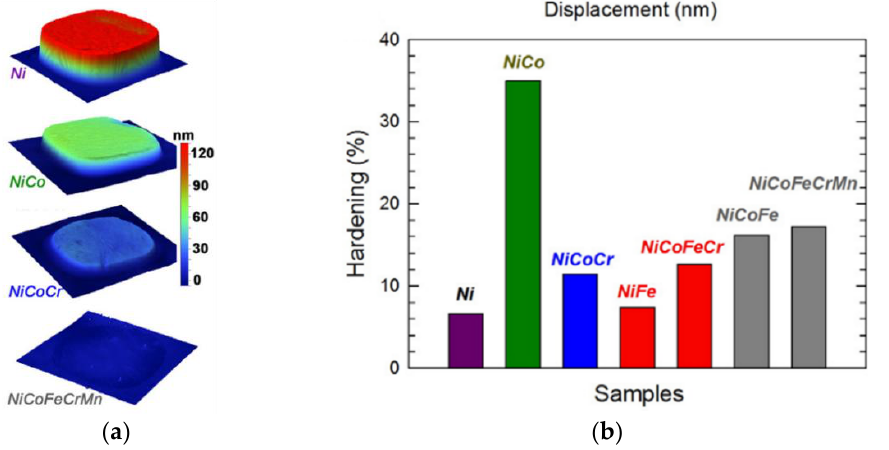
Figure 4. the swelling and hardening of the nickel-contained equal atomic alloys ( a ) the swelling ( b ) the hardening, Reprinted/adapted with permission from Ref. [36]. ( b ) the hardening, Reprinted/adapted with permission from Ref.